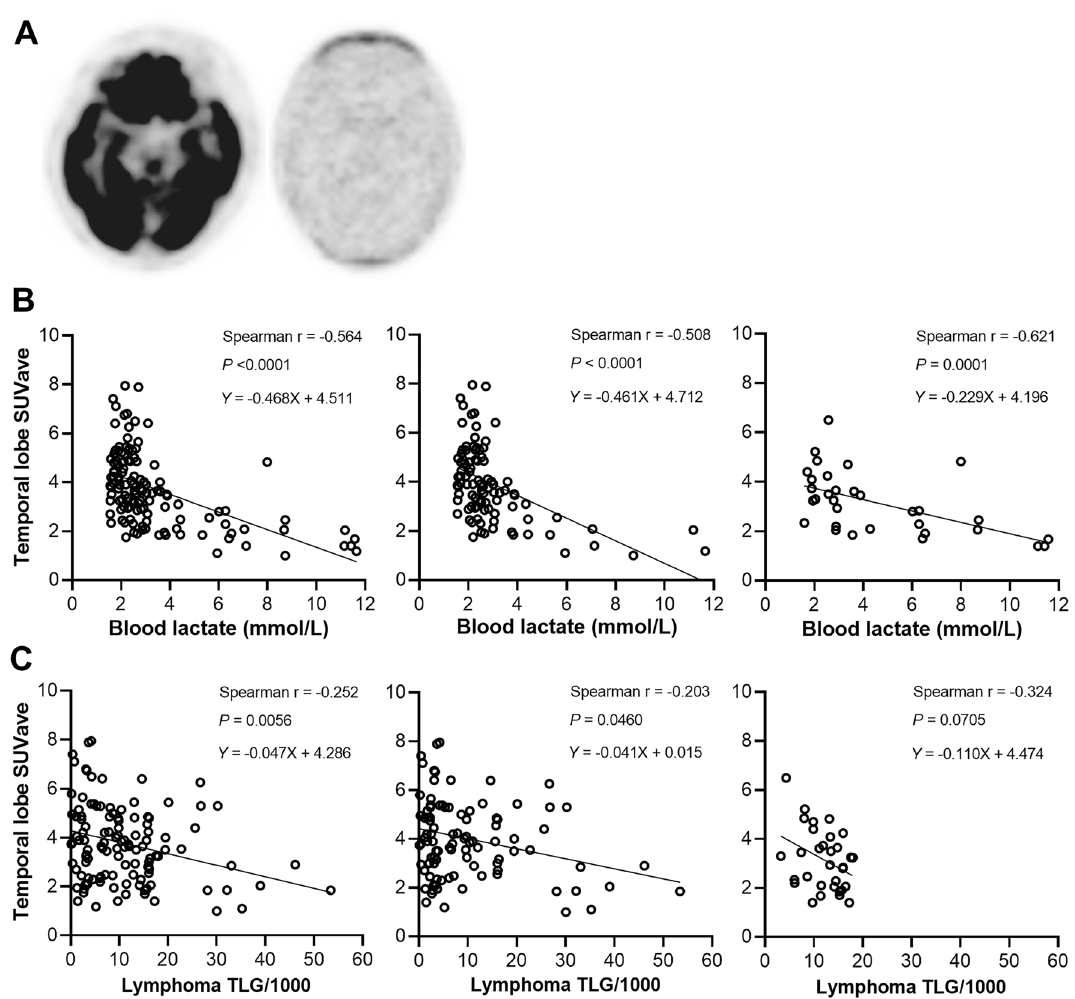
Figure 4. Brain FDG uptake is reduced in a fashion correlating to blood lactate and lymphoma TLG level. ( a ) Representative transaxial FDG brain PET images of a 75-year-old female DLBCL patient who had mildly elevated blood lactate to 1.8 mmol/L and a high temporal cortex SUVave of 6.4 (left) and of a 57-year-old female DLBCL patient with a high blood lactate of 11.7 mmol/L and a severely reduced temporal cortex SUVave of 1.2 (right). ( b , c ) Linear regressions demonstrate significant correlations of temporal cortex SUVave with blood lactate ( b ) and lymphoma TLG ( c ). Groups are the entire population (left), the no hepatic lymphoma group (middle), and the hepatic lymphoma group